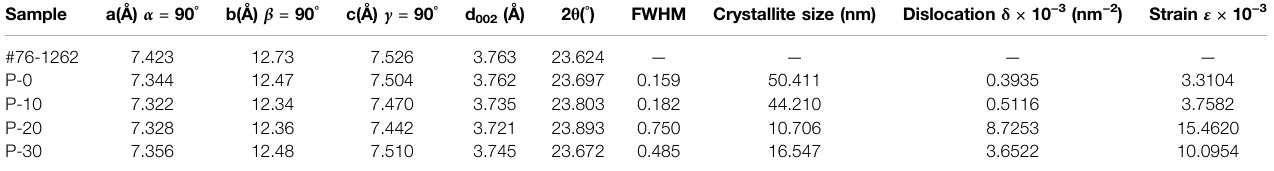
TABLE 1 | Crystallographic parameter of FeF 3 · 0.33H 2 O products with PEG-400 content ranging from 0 to 30 ml were analyzed from the X-ray diffraction patterns. Sample